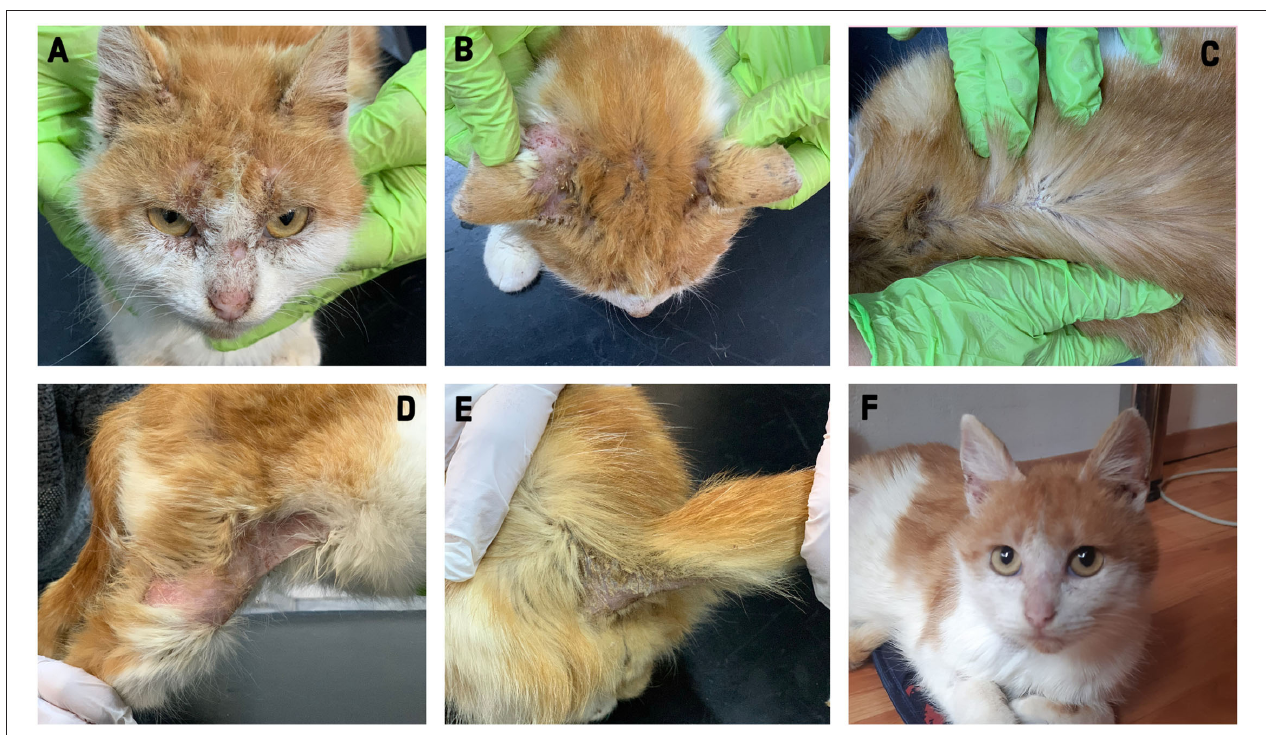
FIGURE 1 | Clinical aspect of the 18-month-old male cat (case 1) before (A–E) and after (F)